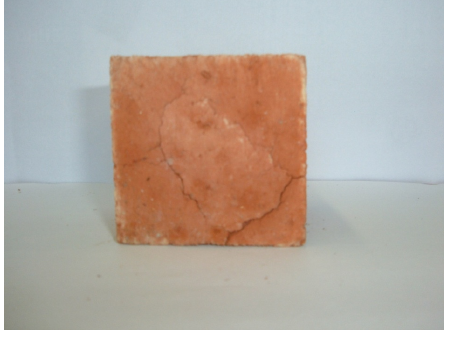
Fig. 2. The sample of batch 1 after burning (Table 2) It can be seen from the empirical equation (4), how the rate of ultrasound spread is influenced by the selec- tion of drying regime. The index of ultrasound spread rate is one of the most important parameters contributing to the evaluation of the level of defects in the sample‘s structure. The drying duration in a laboratory influences the index of ultrasound spread rate below and above the turning point (3067 m/s) differently. The higher the dry- ing stages in the electric stove and in the laboratory, the bigger are the values of ceramics ultrasound spread